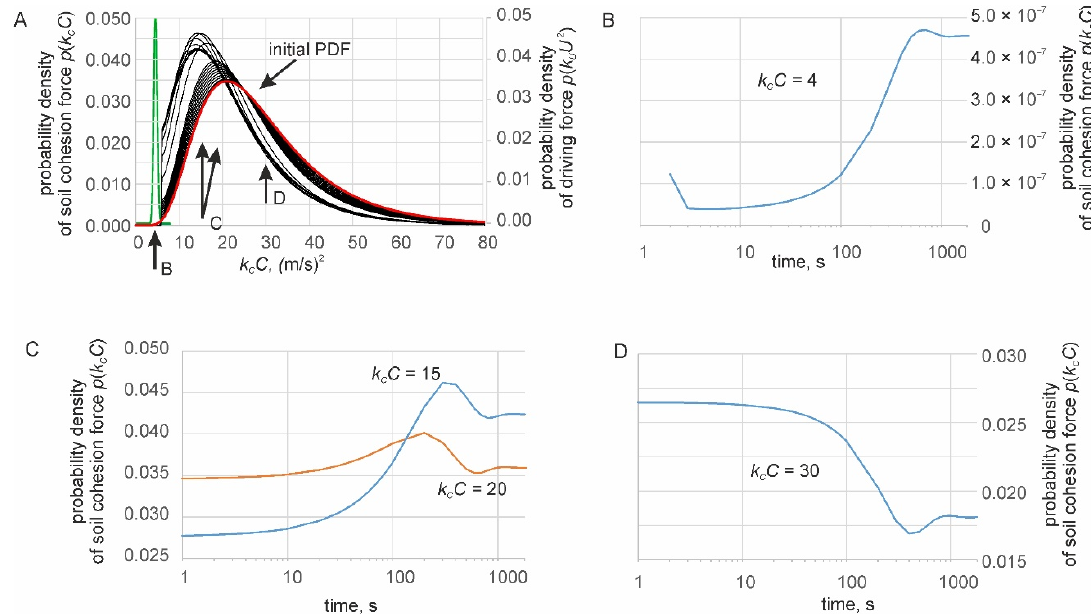
Figure 5. Temporal changes in the PDF of soil cohesion for a flow velocity of 2.15 m/s. ( A ) PDF of driving force (green line) and PDFs of cohesion force, initial (red line) and at the stage of rapid changes (black lines). Two modes show two stage of stabilization. ( B ) Temporal changes in probability density of cohesion force for k C C = 4 m 2 /s 2 at the segment, overlapping with the PDF of driving forces. ( C , D ) Changes in the probability density of cohesion force for k C C = 15–20 and 30 m 2 /s 2 . Numerical experiments for initial k C C = 30, parameter of loosening λ = 0.0015, and other parameters obtained from plot 2.